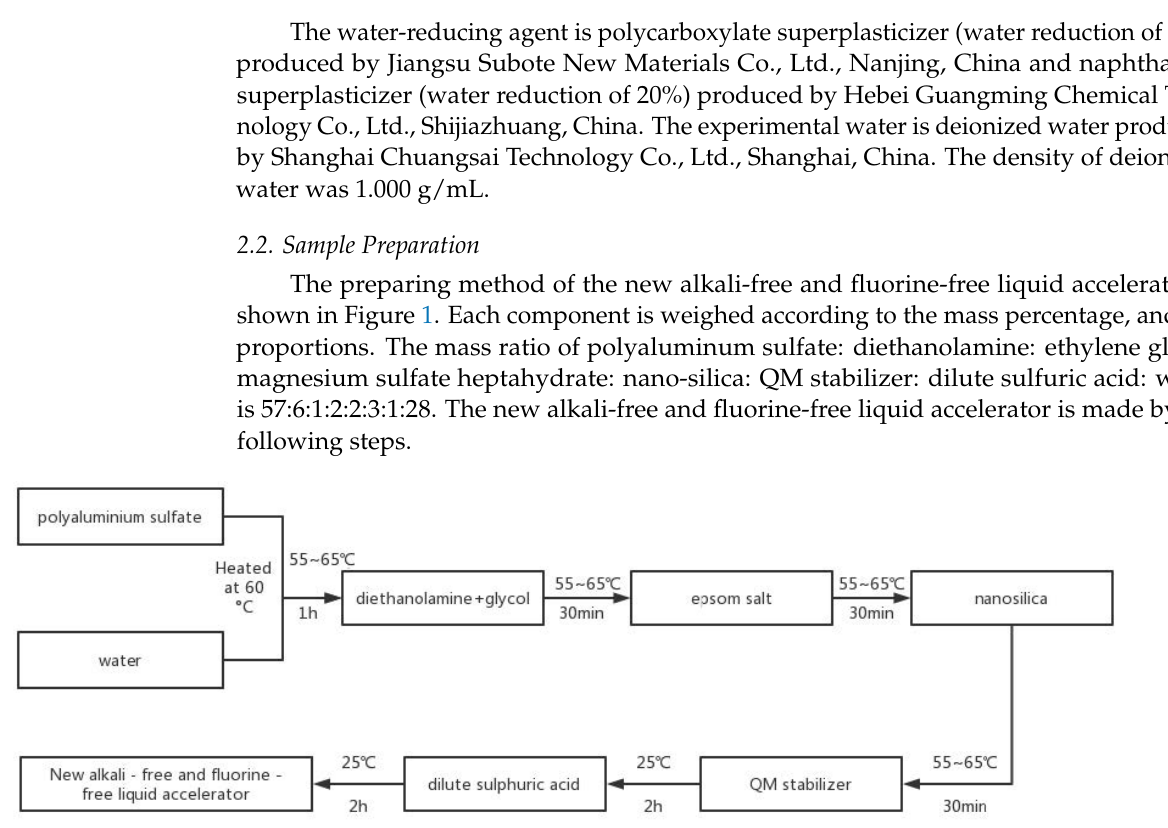
Table 1. Chemical compositions of cement (%).